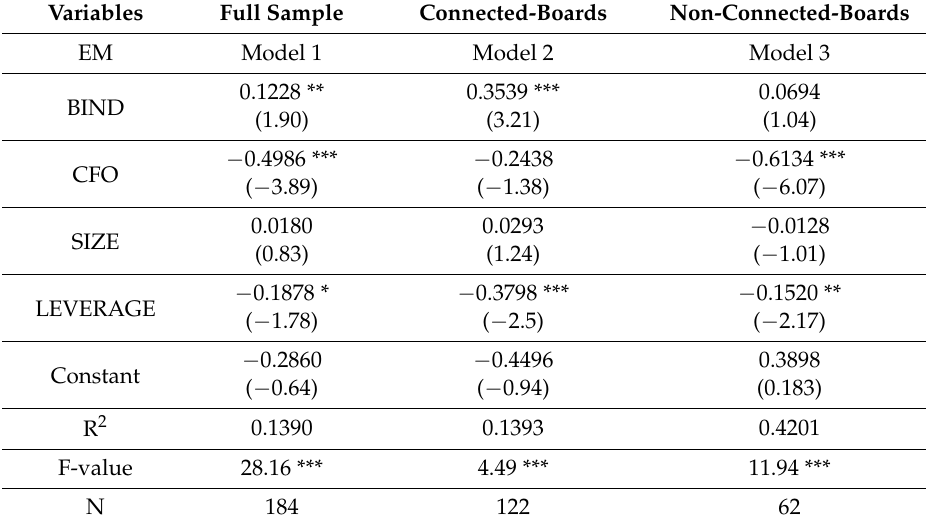
Table A1. Effects of board independence on earnings management in presence social relationships on earnings management.